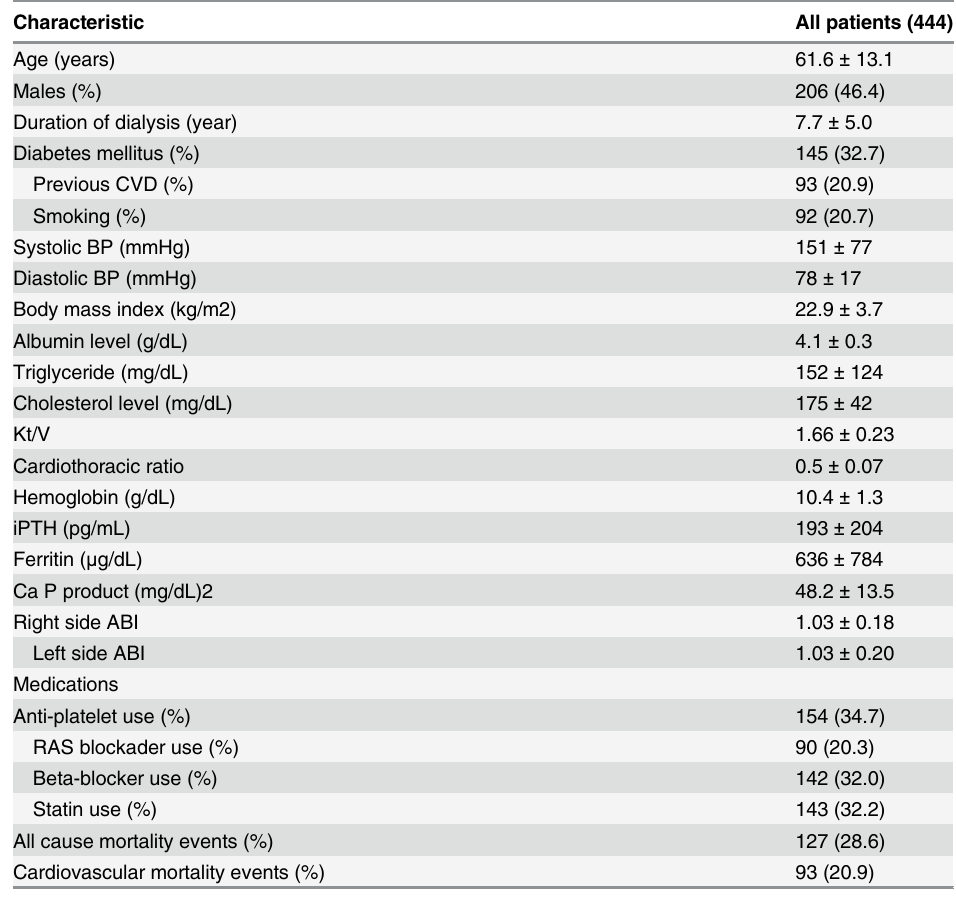
Table 1. Characteristics of study